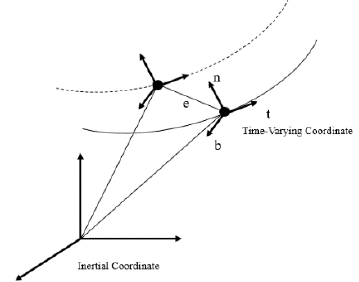
Figure 2. Time-varying coordinate frame